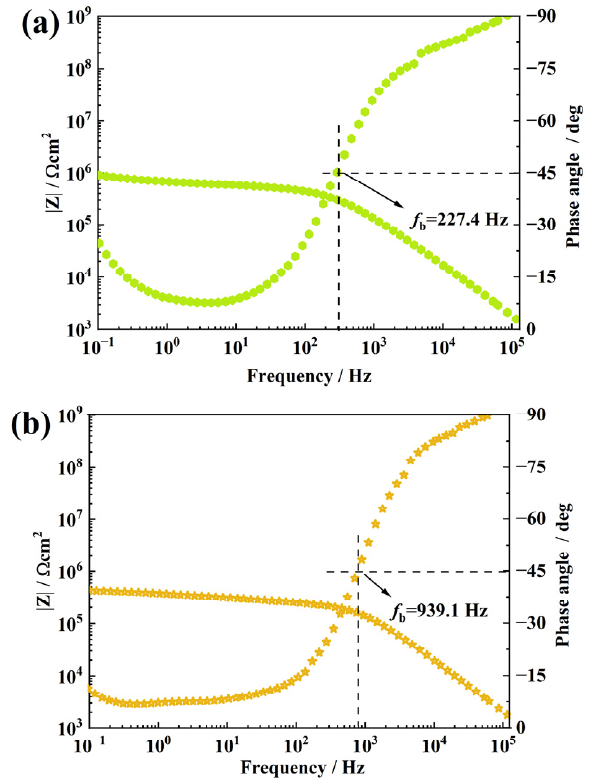
Figure 8. Bode plots of RTV nanocomposite coatings, respectively, filled with 0.7 wt.% ( a ) and 1 wt.% ( b ) f-GO nanosheets after NO2 oxidation.